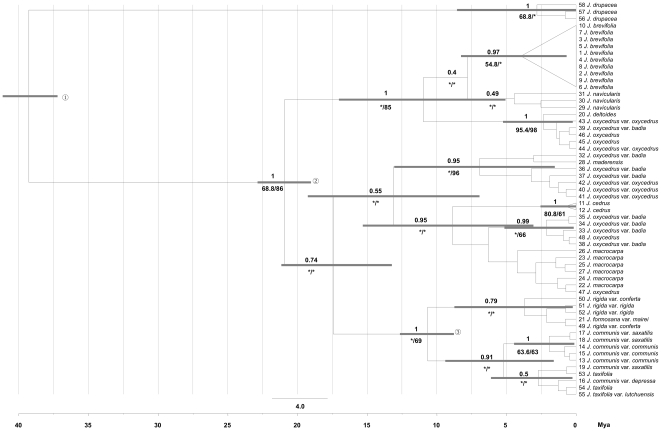
Phylogenetic relationships within Juniperus section inferred from trnL and trnL-trnF, and divergence time-scale derived from BEAST.Numbers before taxon names refer to the coding no. given in Tables 1/S1. Numbers above branches are BEAST posterior probabilities; numbers below branches are Maximum Likelihood bootstrap support values (before slashes); and Maximum Parsimony bootstrap support values (after slashes). Asterisks indicate absence of support. Gray bars represent divergence times (95% highest posterior density intervals) for each node, while numbers in white circles represent calibration points obtained from Mao et al. [42]: (1) split between sects. Juniperus-Caryocedrus (49.1–29.9 Mya), (2) crown of sect. Juniperus (29.9–11.1 Mya) and (3) crown of BSG in sect. Juniperus (17.5–4.7 Mya). BEAST posterior probability values for calibration nodes were inferred from Mao et al. [42].